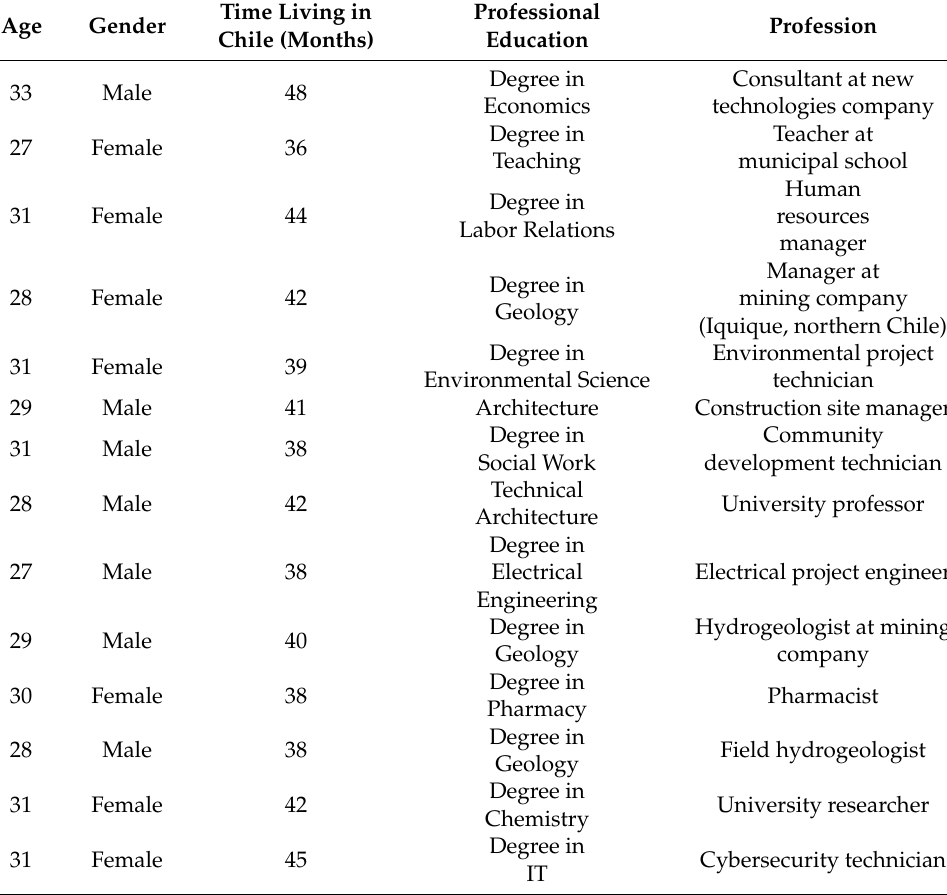
Table 2. Profiles of the interviewees living in